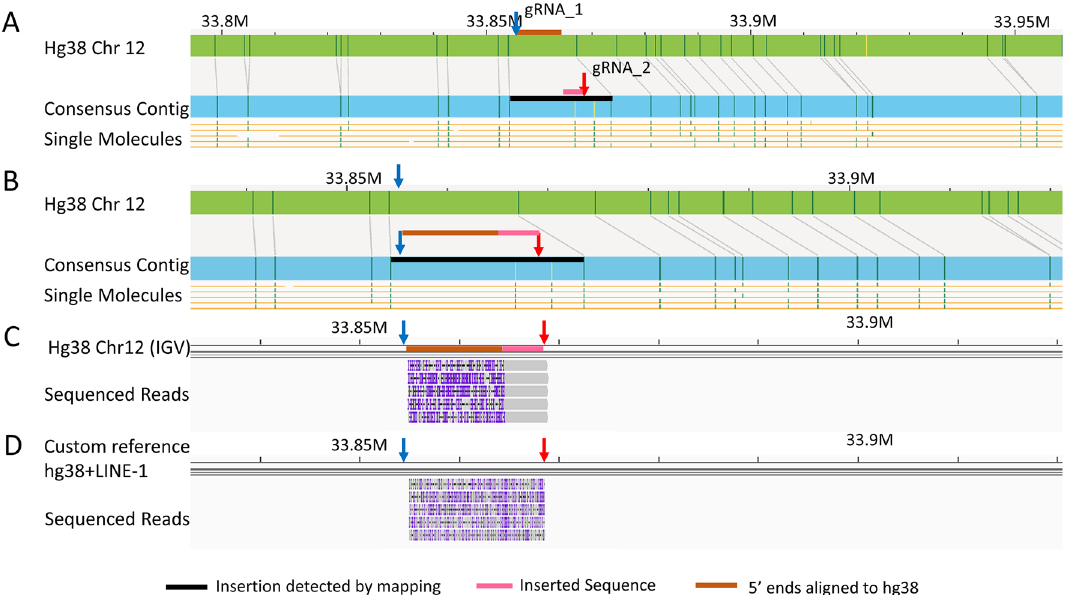
Figure 3. An insertion detected with optical mapping resolved with our cas9-assisted targeted nanopore sequencing approach. ( A ) Shows a black bar at the location where the insertion was detected on chromosome 12 contig by optical mapping. ( B ) Shows a zoomed in view the insertion on the contig and the gRNA pair, blue and red arrows, designed to target this region. The brown and pink bars represent the expected fragment generated by the gRNA pair. The brown bar represents part of fragment aligning to hg38 and the pink bar represents part of fragment containing partial insertion sequence. ( C ) Shows the sequenced reads aligning between the designed gRNA cut sites. Coverage was 5X. All fragments had two segments as expected. The part of reads representing aligning portions are marked by a brown bar on the IGV reference. The part of reads not aligning are marked by the pink bar. ( D ) Shows the same reads aligning to a custom reference where the reference consisted of hg38 sequence with a LINE-1 reference inserted at the detected